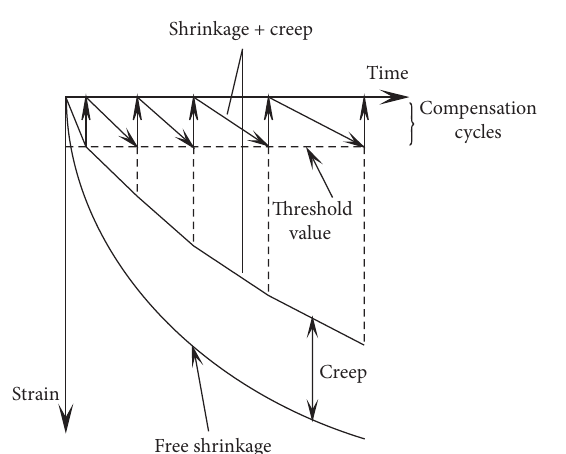
Figure 4: The TSTM test [34].